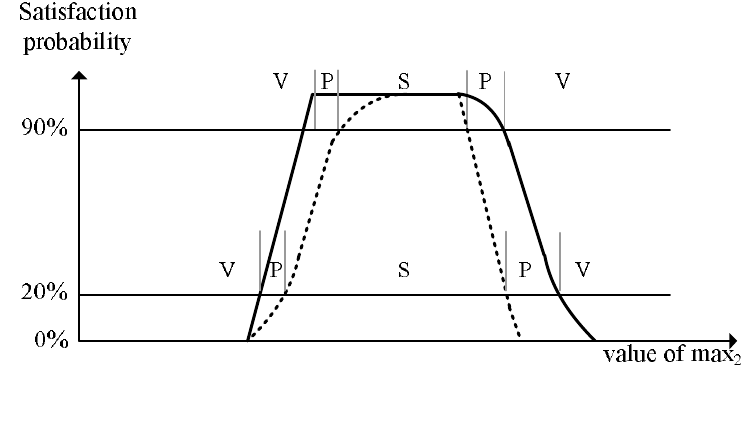
Figure 9. The interval timing correlation with high and low confidence